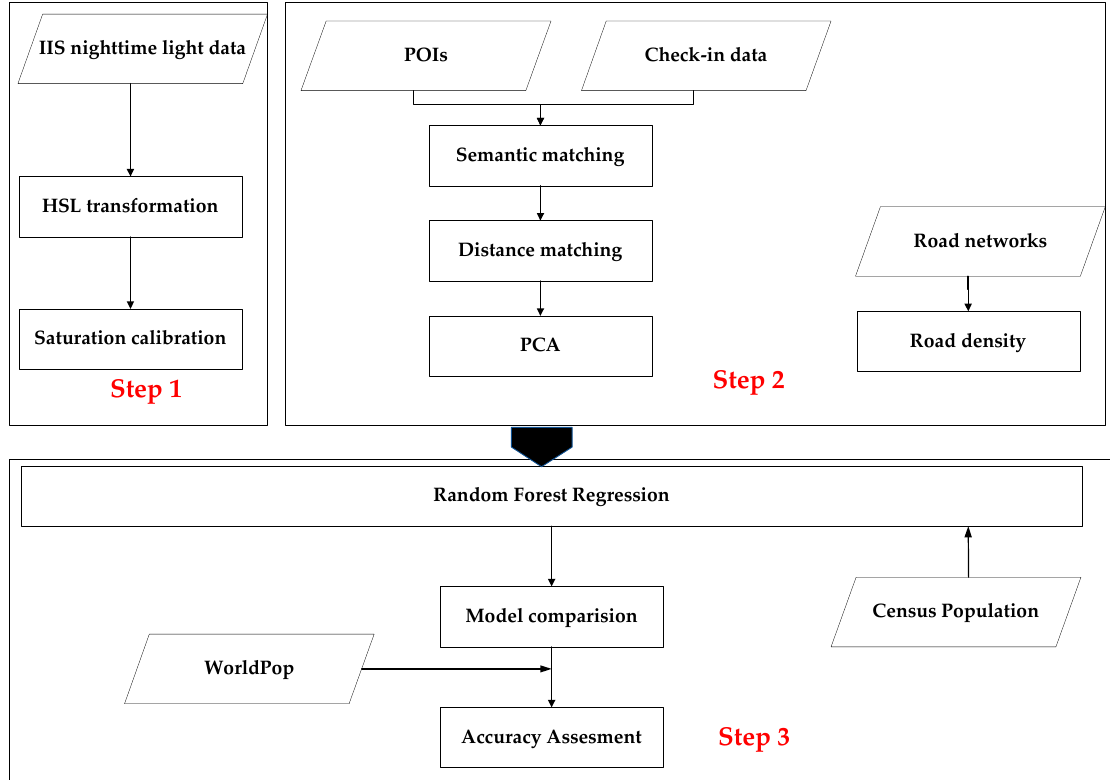
Figure 2. Flowchart of the proposed population mapping.